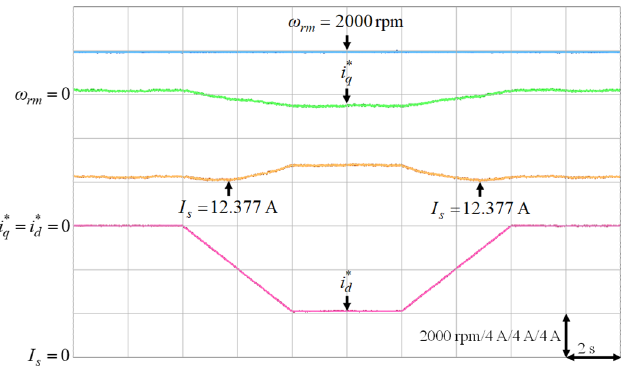
Figure 20. Experimental results of finding the lowest stator current at 2000 rpm with 9.5 Nm. Table 4. Comparison of stator current amplitude.